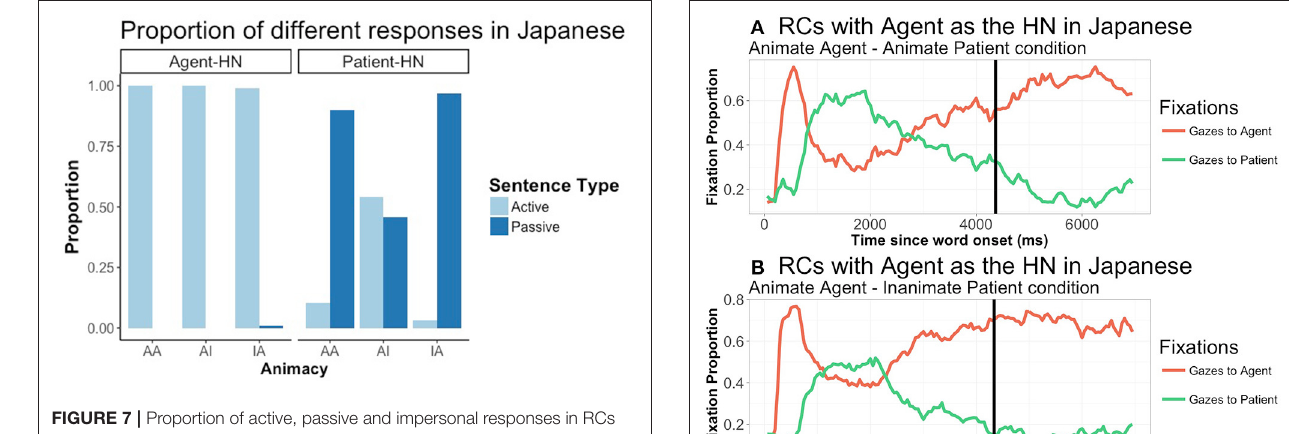
animate HNs to the subject function despite its final position ( Figure 7 ).